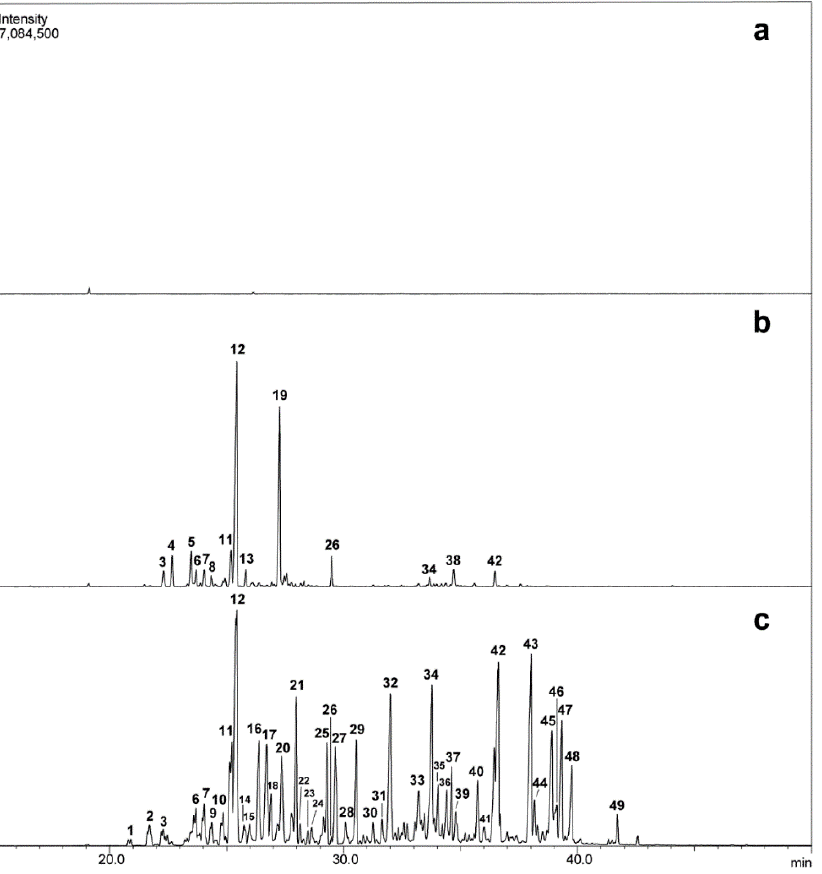
Figure 2. Headspace solid-phase microextraction and gas chromatography coupled with mass spectrometry (HS-SPME GC/MS) analysis of vetiver root volatile organic compounds (VOCs). Plants were grown ( a ) in vitro, ( b ) in HPA or ( c ) in potting soil. Table 1. Vetiver VOCs observed during GC/MS